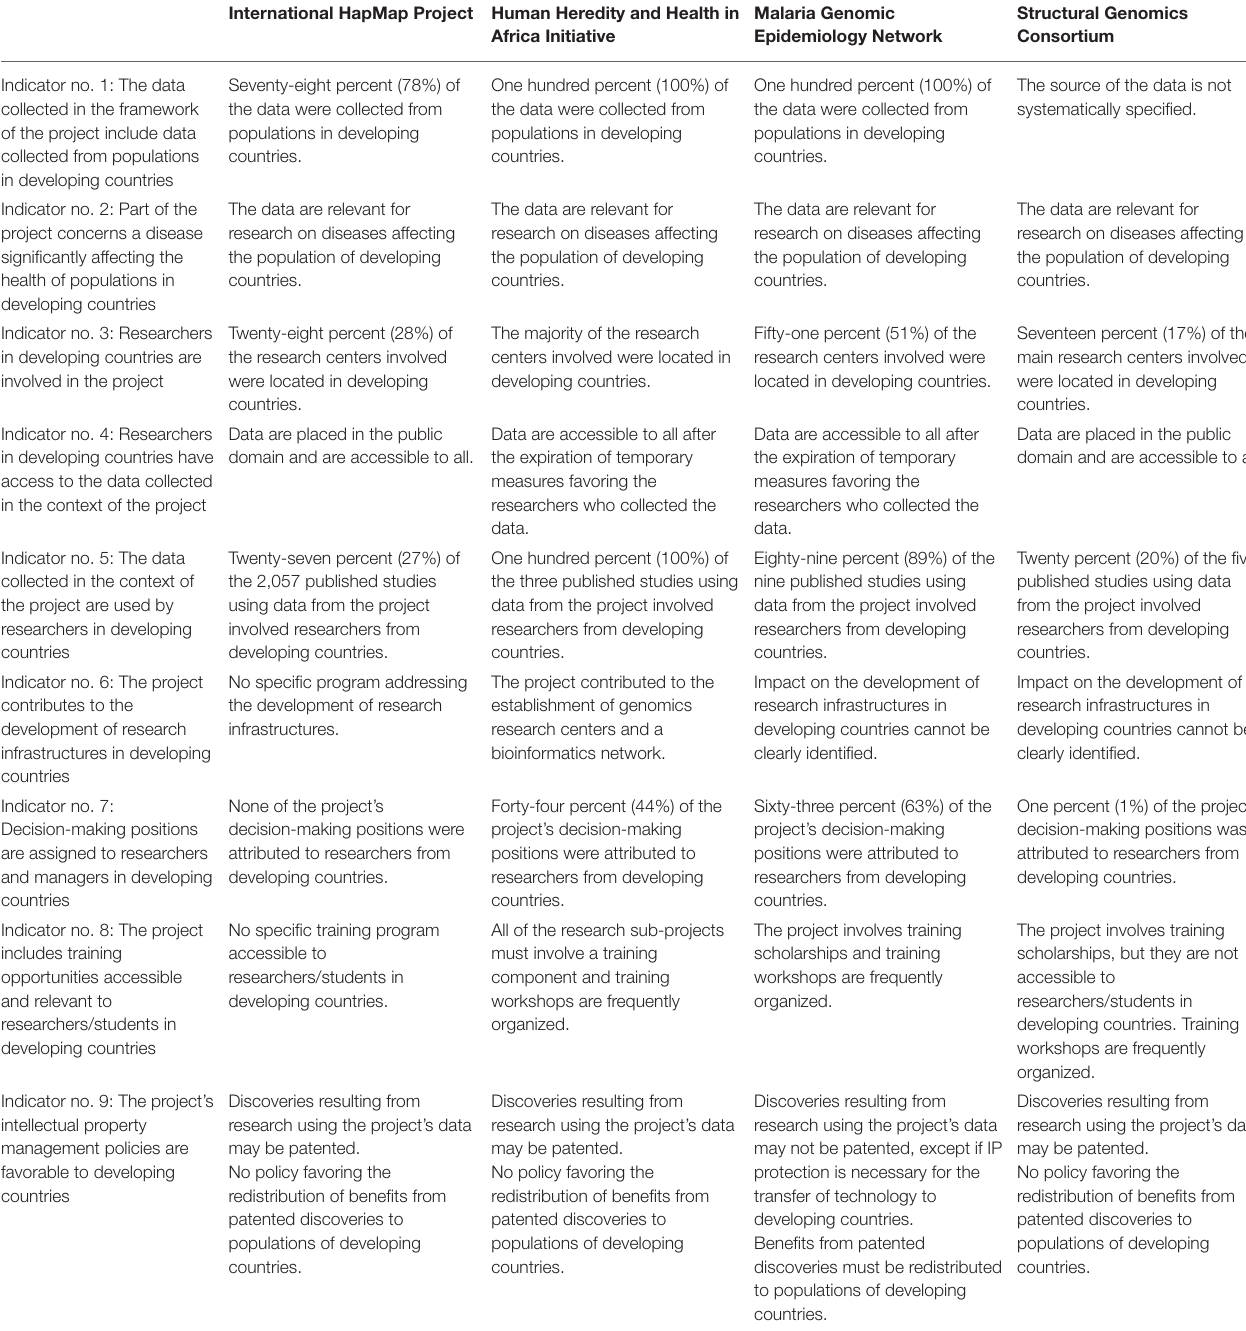
TABLE 3 | A first look at the impact of international open science genomics projects on capacity building in the developing